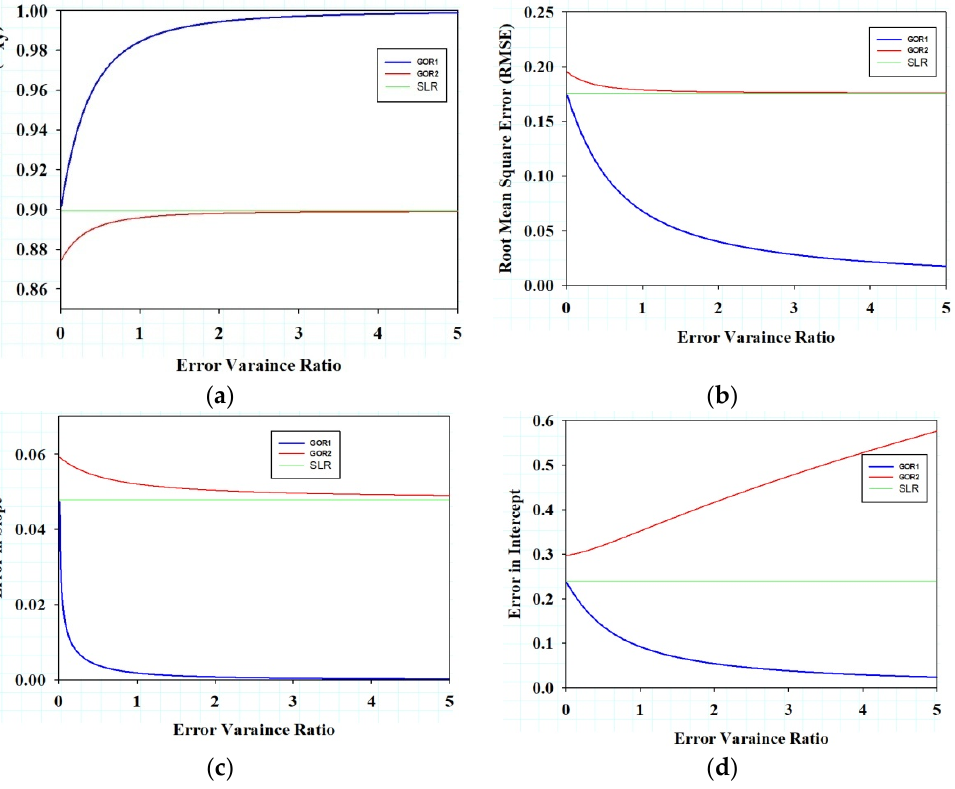
Figure 6. Comparison of the uncertainty in regression parameters for (M S,NEIC – M wg ) data pairs using GOR1, GOR2, and SLR approaches considering function of error variance ratio: ( a ) Correlation Coefficient determination (R xy ), ( b ) Root mean square error (RMSE), ( c ) uncertainty values of slope and ( d ) uncertainty of intercept.